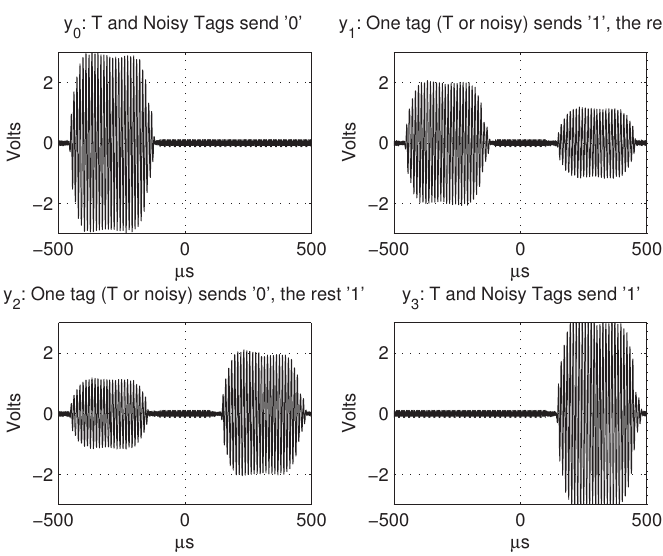
= y 0 , y 1 , y 2 , y 3 Y {